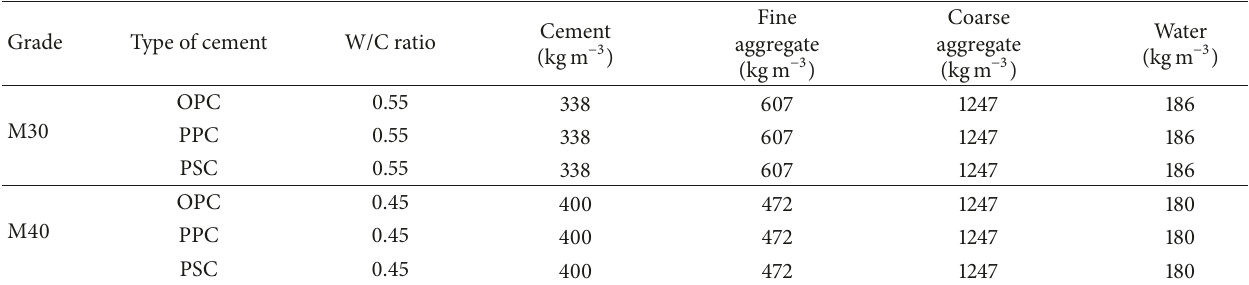
Table 1: Details of concrete mix proportions.